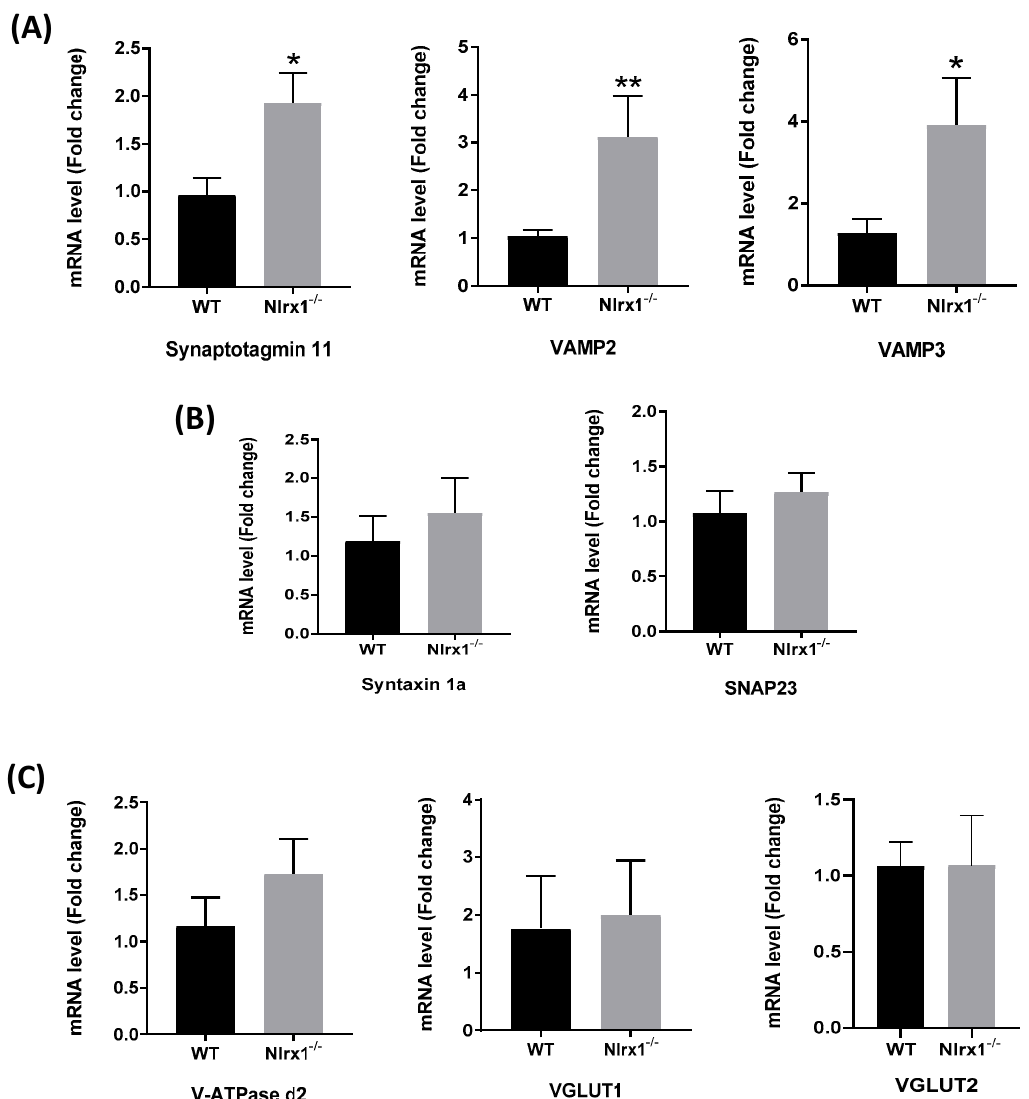
Figure 3. Increased mRNA expression of the proteins of exocytosis in Nlrx1 - / - astrocytes. mRNA expression of the proteins of exocytosis in WT and Nlrx1 - / - astrocytes shows ( A ) significant upregulation of mRNA expression of the Ca 2 + sensor, synaptotagmin 11, and vesicular fusion proteins, VAMP2 and VAMP3, in Nlrx1 - / - astrocytes compared to WT; ( B ) no significant change in the cell membrane fusion proteins’ mRNA expression; and ( C ) no significant change in the expression of the proteins upstream of Ca 2 + release from the ER. ** p < 0.01 and * p < 0.05 as determined by Mann–Whitney test (n ≥ 5), results are presented as mean ± SEM.